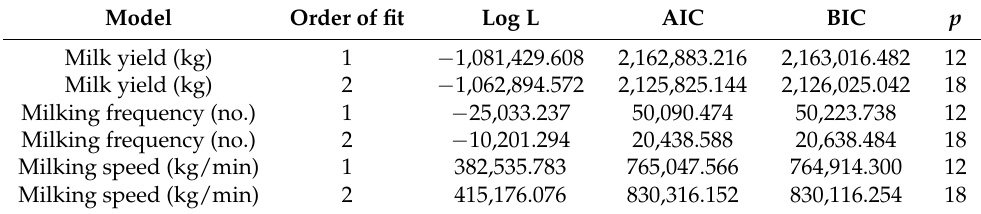
Table 2. Number of parameters (P), log-likelihood value (Log L), Akaike’s information criterion (AIC) and Bayesian information criterion (BIC) for different models in single trait random regres- sion analysis.